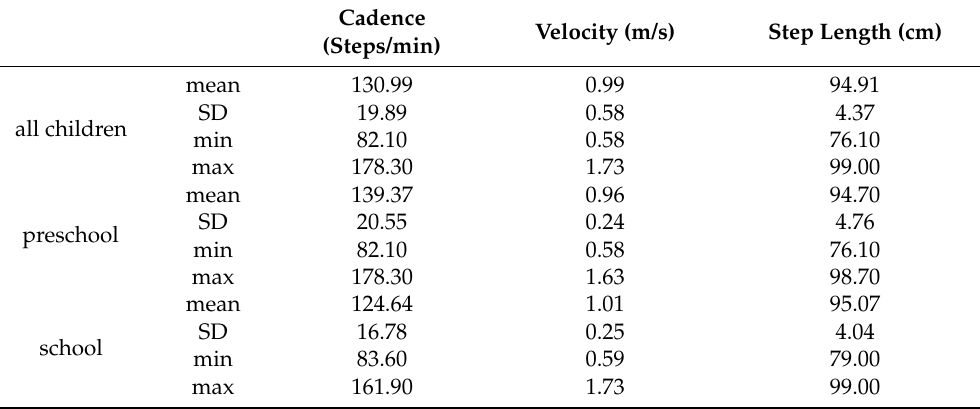
Table 5. Characteristic of cadence, velocity and step length in all examined groups as well as in age groups